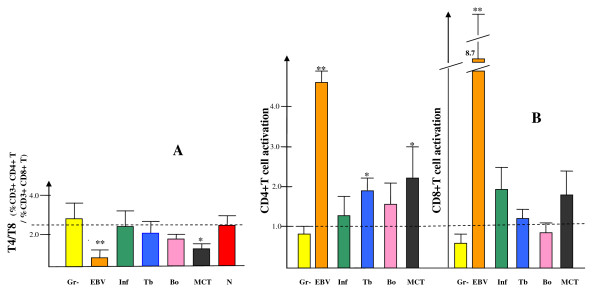
T lymphocytes: (A), ratio of CD4+/CD8+ T cells; (B), activation within the CD4+ and CD8+ T cell subsets. The result for T cell activation shows the percentage of HLA class II-expressing cells among all CD4+ T cells and CD8+ T cells, respectively. The indicated activation values are normalized with the result of the normal control individuals being expressed as 1.0, and the dashed lines indicate the level of the normal controls. Patient group codes: Gr-, septicaemia and/or pyelonephritis with gram-negative enterobacteria; EBV, Epstein-Barr virus; Inf, influenza; Tb, tuberculosis; Bo, neuroborreliosis; MCT, mixed connective tissue disorders; N, normal healthy controls. *p < 0.02 or 0.05, ** p < 0.01.